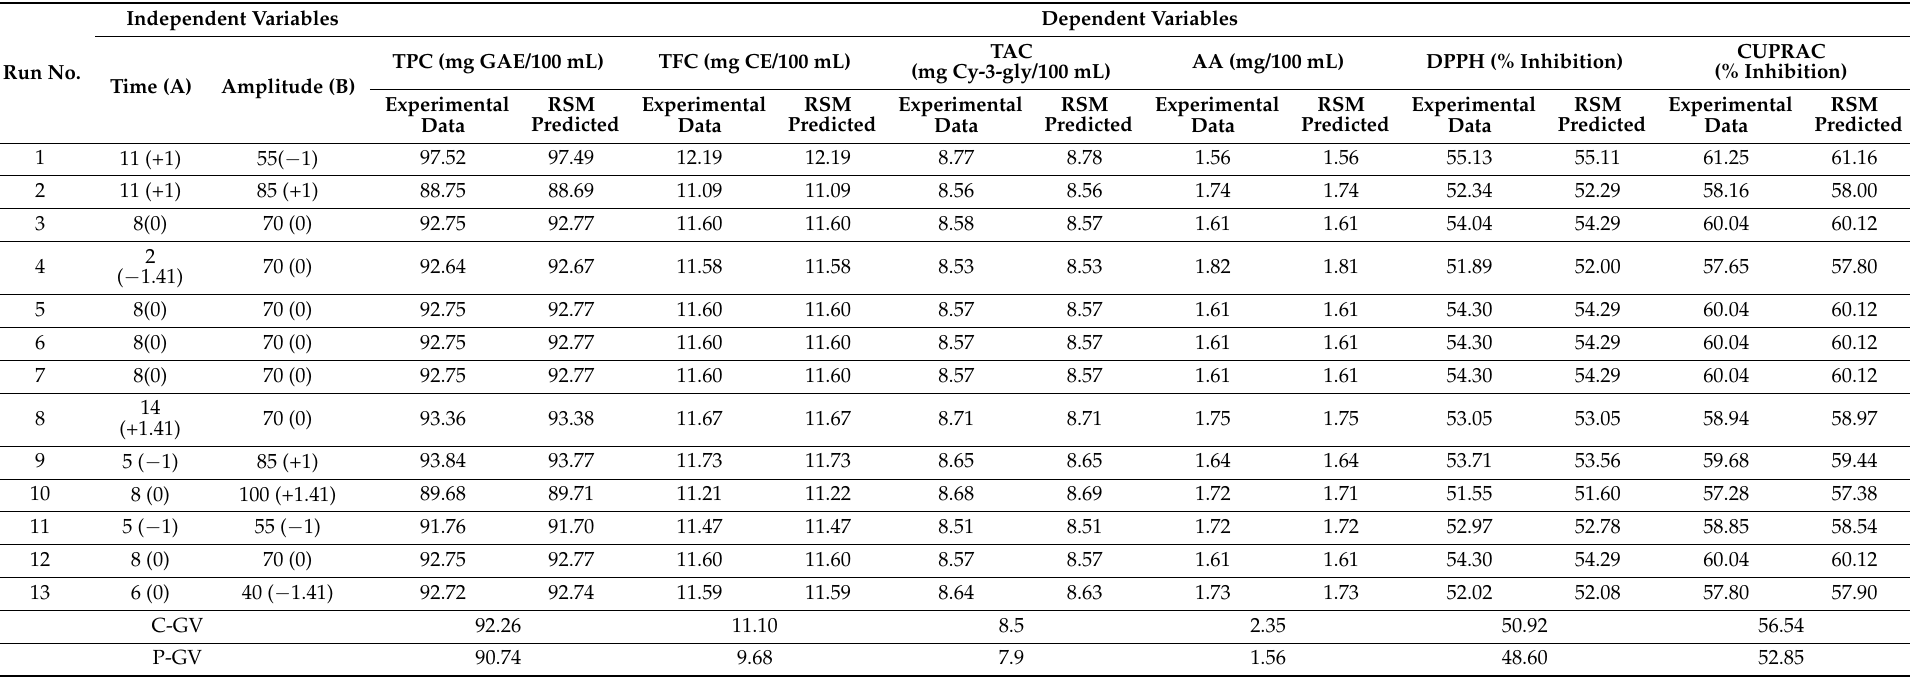
Table 2. Measured responses used in the experimental design for RSM and results of C-GV and P-GV.